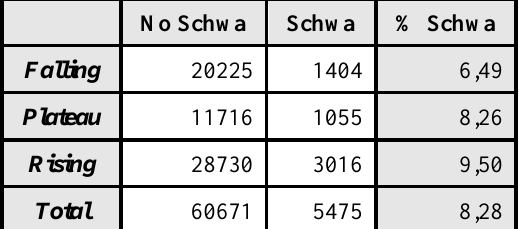
Table 6. Number and rates of schwa according to the sonority sequence of a simplex coda followed by a simplex